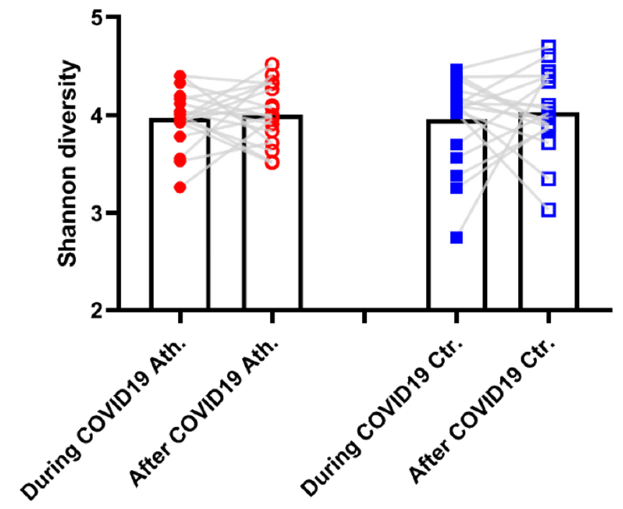
Figure 4. The Shannon diversity of the samples. The Shannon diversity was evaluated and the results are shown on the figure. The Shannon diversity of the microbiome was independent from training status or COVID-19 infection. n = 38.